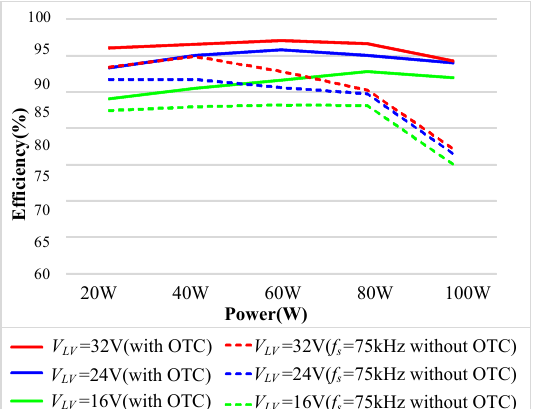
Figure 18. Experimental efficiency at different load comparison between OTC and traditional meth ‐